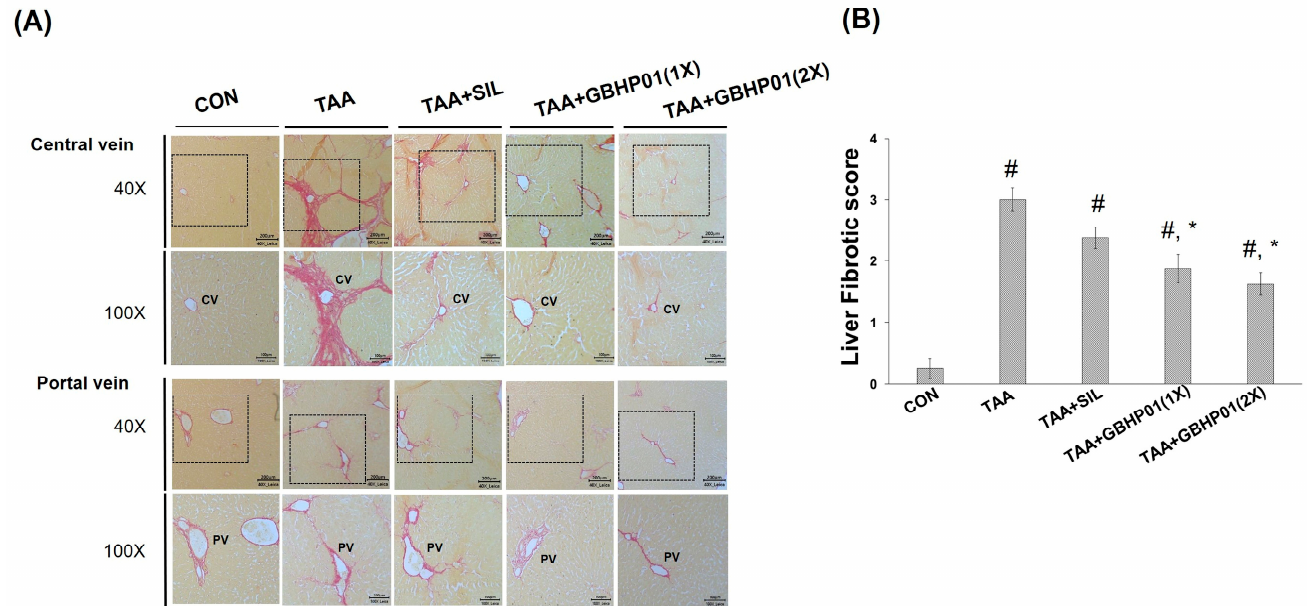
Figure 2. Effects of chicken liver hydrolysate-based supplement (GBHP01 TM ) on ( A ) Sirius red- stained illustrations of liver tissues of experimental rats (40× and 100×) and ( B ) the fibrotic scores according to Sirius red-stained observations of liver tissues. Data are given as mean ± SEM (n = 8). #: Signifcance against CON group ( p < 0.05); *: Signifcance against TAA group ( p < 0.05).